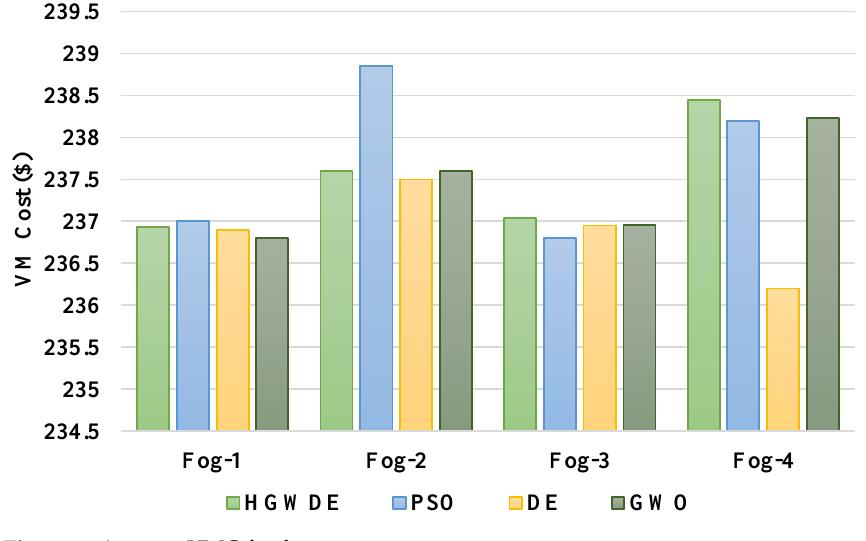
Figure 6. Average VMC for fogs.